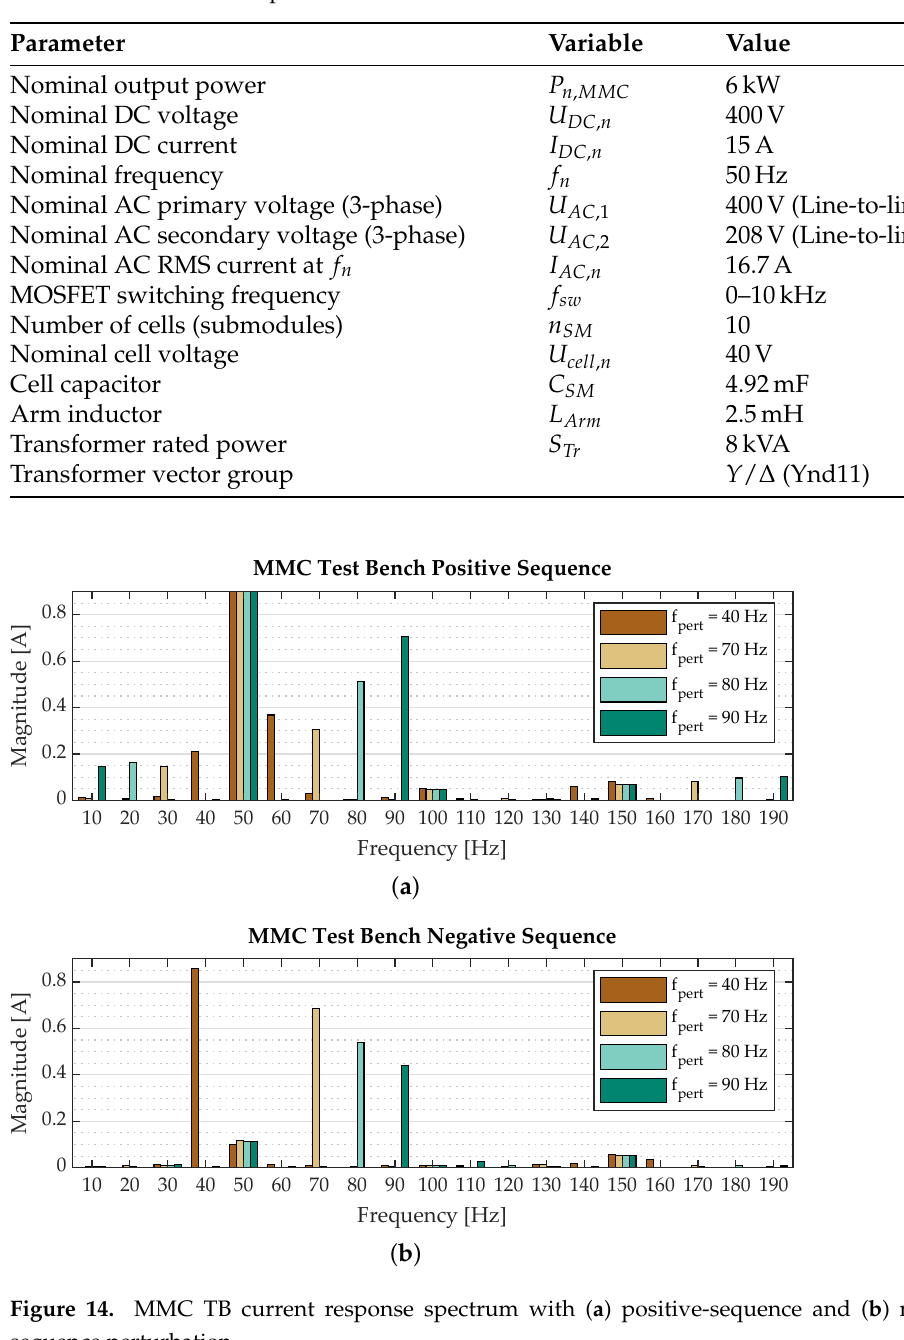
Table 4. MMC Test Bench parameters.